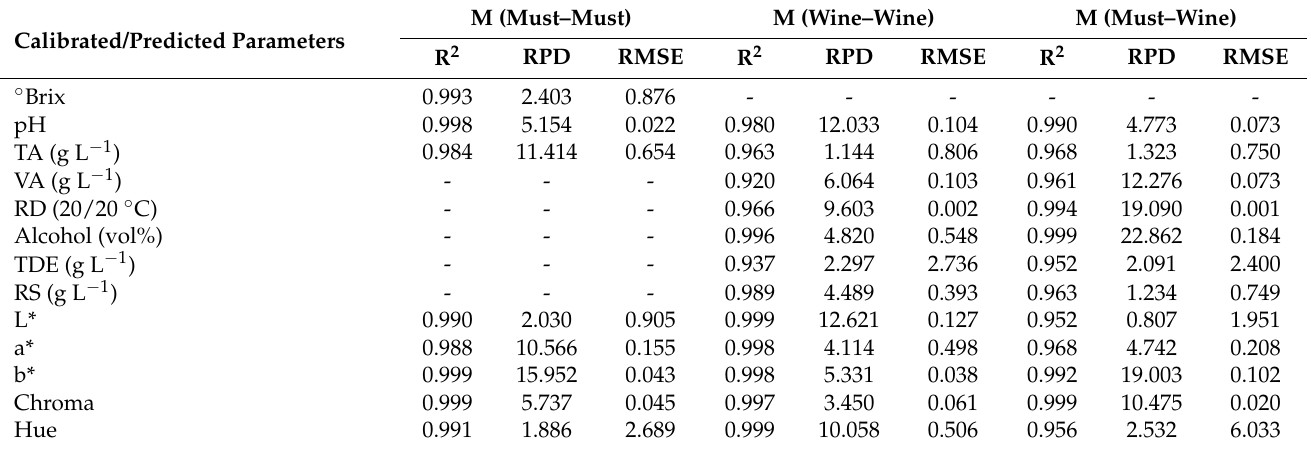
Table 2. Calibration of wine parameters based on the physicochemical data and colour of must.